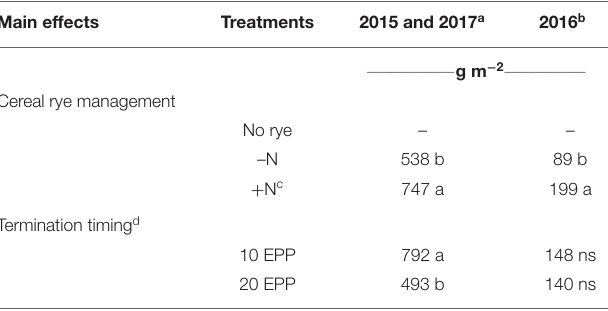
TABLE 2 | Infuence of cereal rye management and termination timing on cereal rye biomass production.